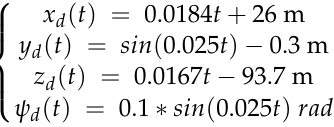
( f ) Figure 12. AUV position − tracking errors. ( a ) 𝑥 𝑒 ; ( b ) 𝜑 𝑒 ; ( c ) 𝑦 𝑒 ; ( d ) 𝜃 𝑒 ; ( e ) z 𝑒 ; ( f ) 𝜓 𝑒 .